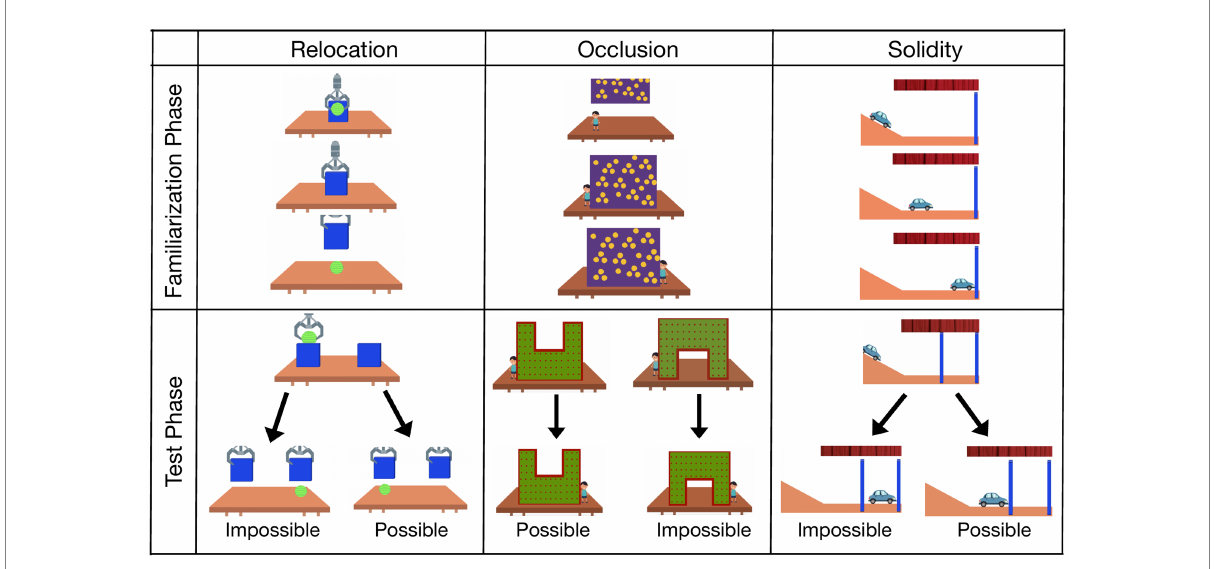
FIGURE 1 Sequence of still images of three different types of physical events shown in the violation-of-expectation tasks. In each event, infants were shown a familiarization phase (repeated twice) followed by two test events that contained either a possible or matched impossible outcome. All events in the test phase ended with a 10-s freeze-frame of the outcome event during which time infants’ cumulative looking at the screen was